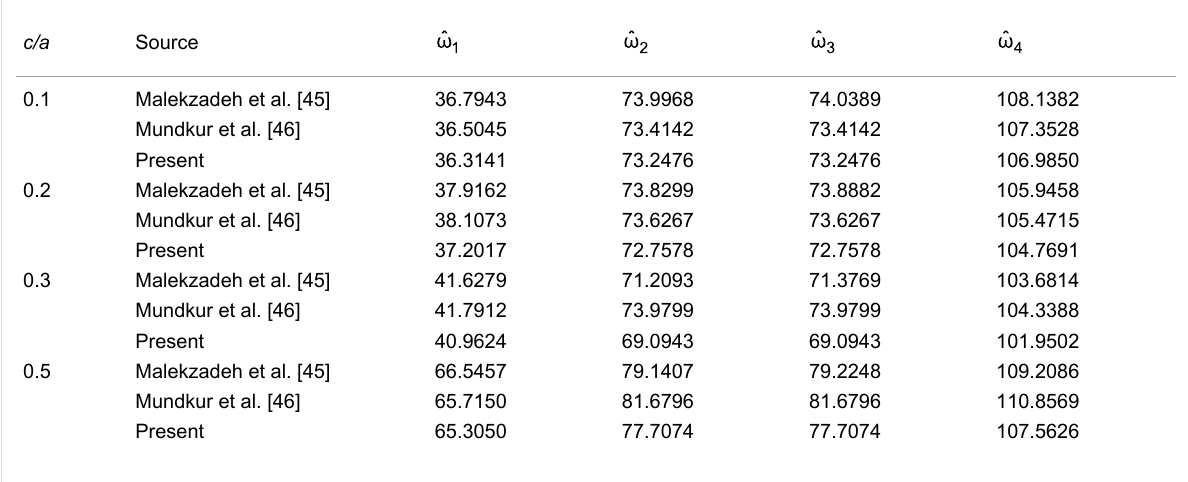
Table 3: First four frequency parameters